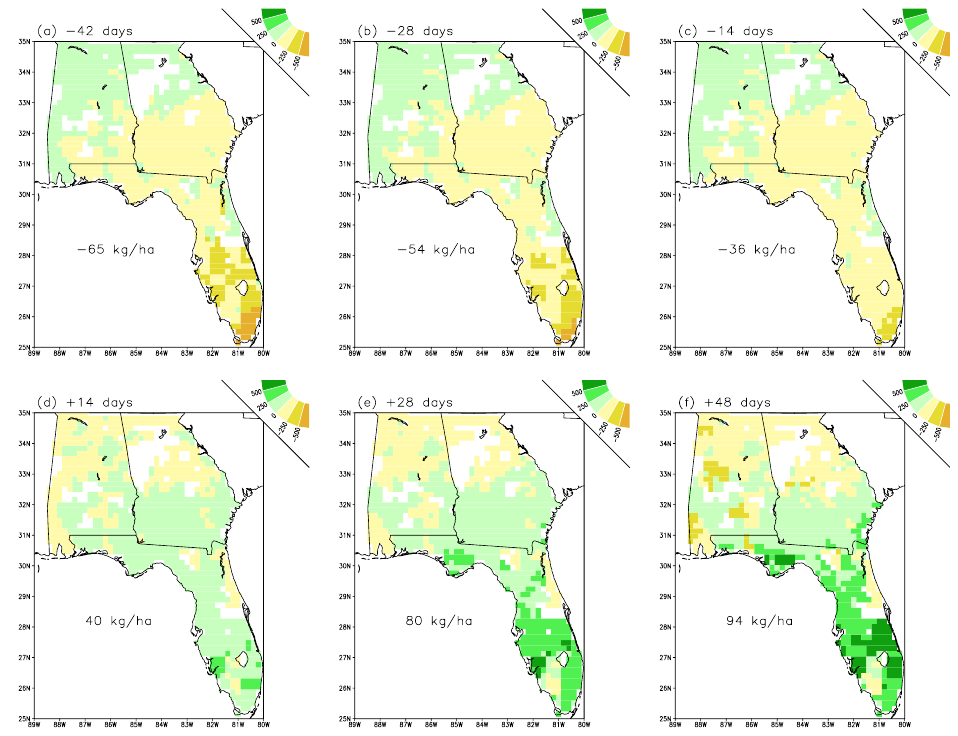
Figure 8. As in Figure 7, but for peanut using the NARCCAP HH model. The control planting date is 25 April.